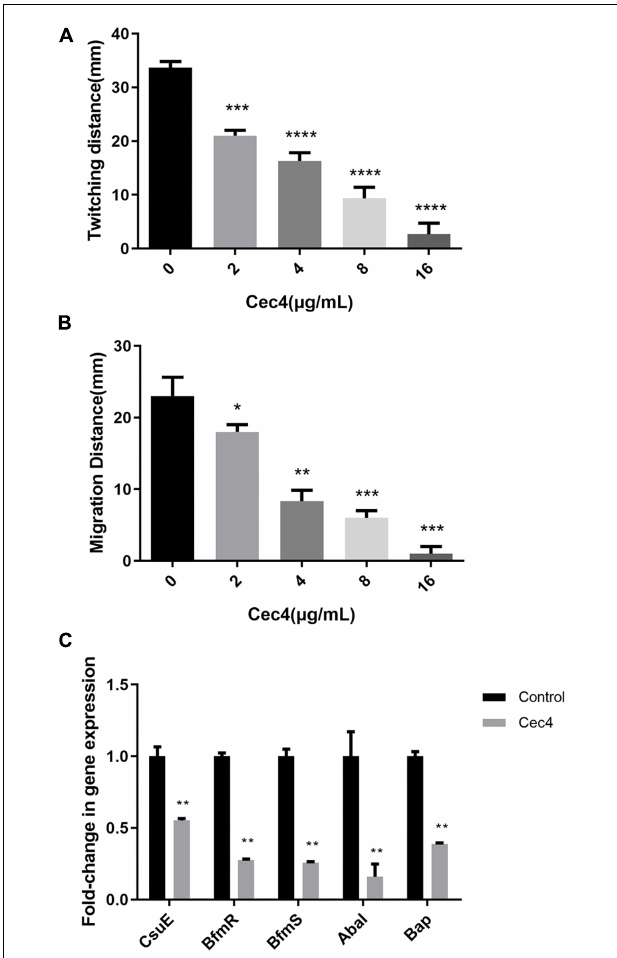
FIGURE 4 | The motility of CRAB and biofilm involved genes were affected after treated with Cec4. Twitching motility (A) and surface-associated motility (B) of CRAB were quantitated from three separate experiments at 37 ◦ C. Error bars represent standard deviation of the mean. * p < 0.05; ** p < 0.01; *** p < 0.001; **** p < 0.0001. (C) Effect of Cec4 on the expression levels of biofilm involved genes in CRAB strains. Error bars represent the standard deviations. ** p <